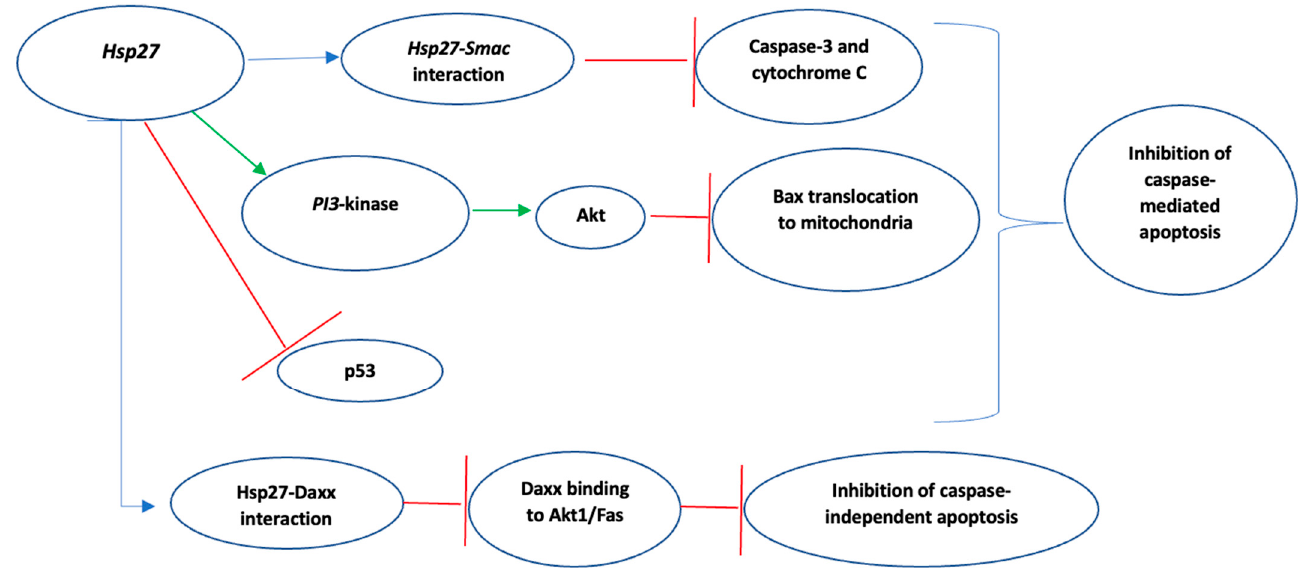
Figure 4. Summary of Hsp27-mediated inhibition of apoptosis. Green indicates activation, Red indicates inhibition. Key: PI3, phosphatidylinositol-3-kinase.